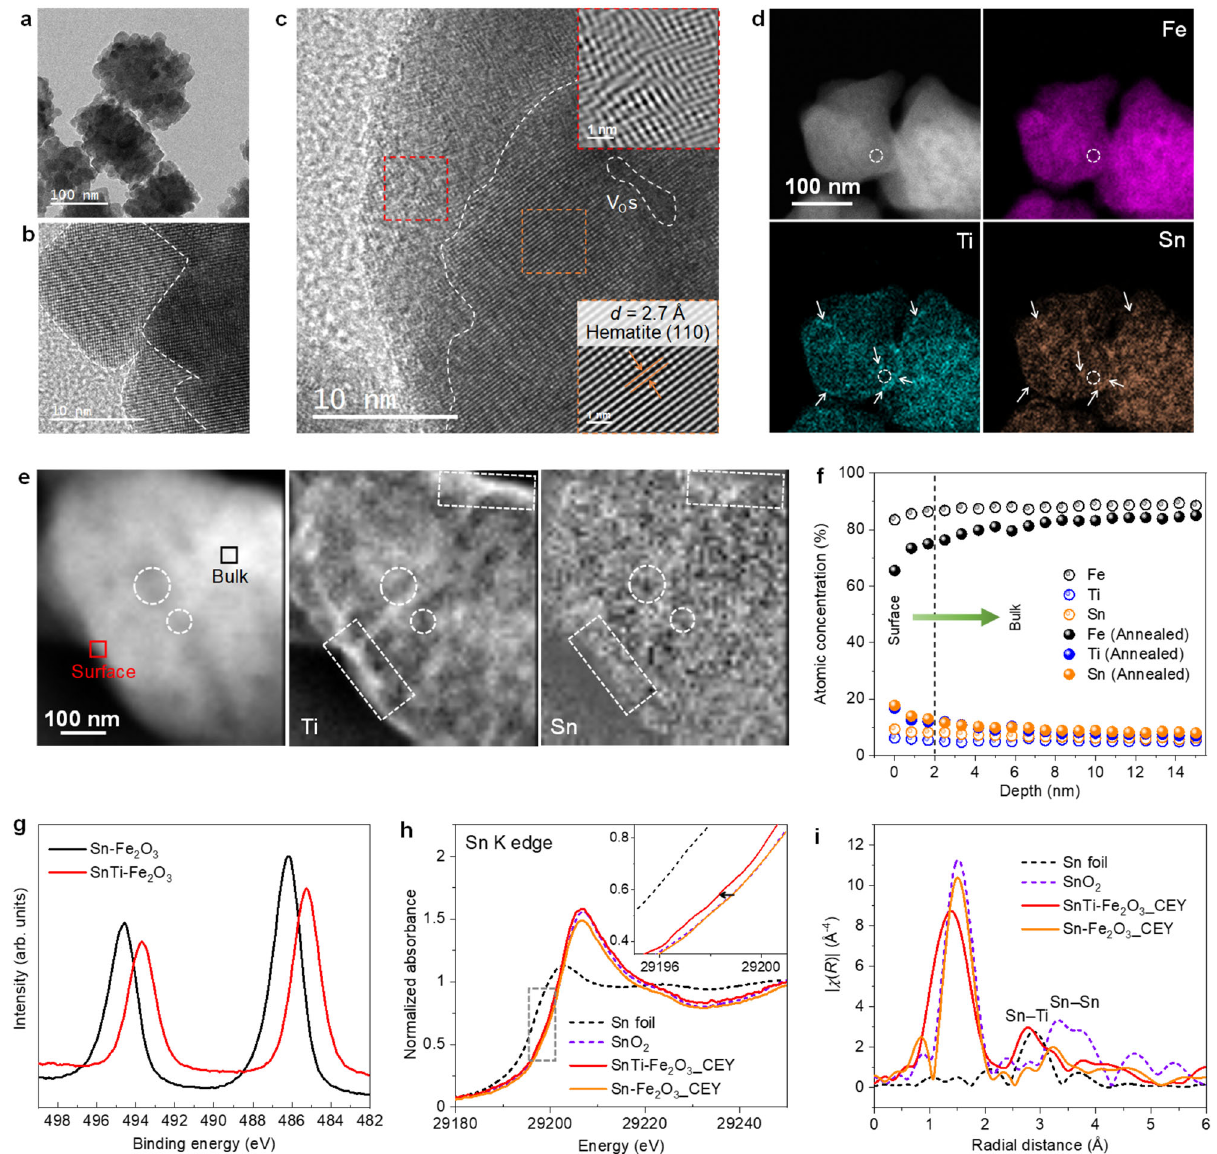
annealed SnTi – Fe 2 O 3 MC. Insets indicate inverse fast Fourier transform (FT) images of the selected regions with the same colors as indicated by the dashed frames. d HAADF-STEM images and corresponding EDX chemical composition maps of annealed SnTi – Fe 2 O 3 MCs. e HAADF-STEM image (left) and corresponding EELS composition maps of Ti (451.7 – 469.7 eV) (middle) and Sn (507.5 – 525.5 eV) (right) signals of a typical annealed SnTi – Fe 2 O 3 MC. f XPS depth analysis of the as-synthesized and annealed SnTi – Fe 2 O 3 samples. g Sn 3 d XPS spectra of annealed SnTi – Fe 2 O 3 and Sn – Fe 2 O 3 MCs. h Ex situ